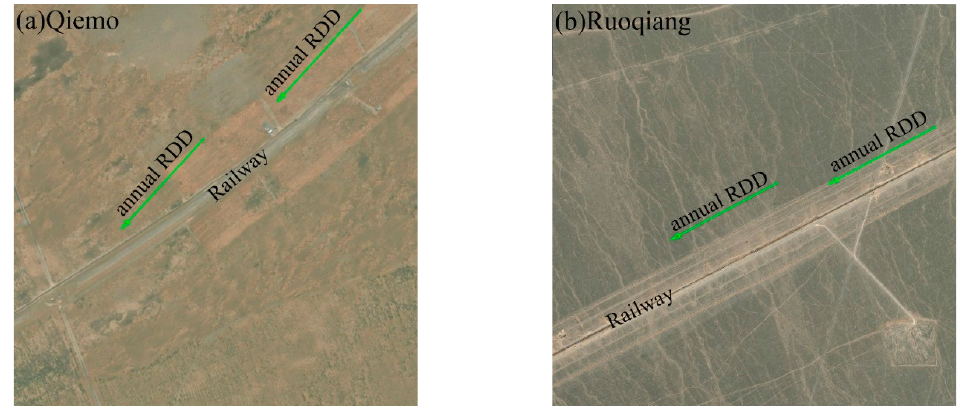
Figure 10. Railway trend and annual RDD: ( a ) Qiemo; ( b ) Ruoqiang.